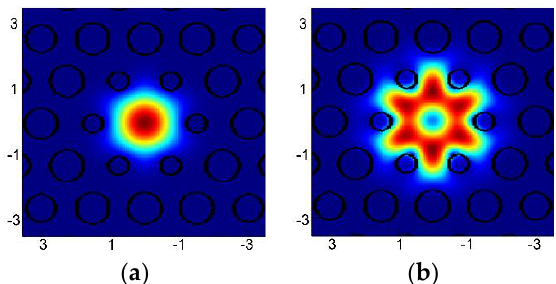
Figure 7. Numerically simulated distributions of intensity of modes for the wavelength of 1.56 µm: ( a ) fundamental mode LP 01 , ( b ) mode LP 31 .